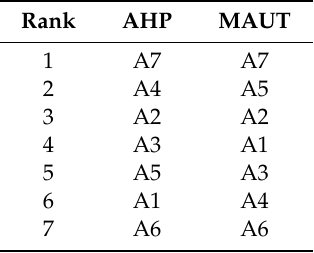
Figure 9. Alternatives’ scores by methodology (AHP and MAUT). Table 6. Alternatives’ rankings by methodology (AHP and MAUT).